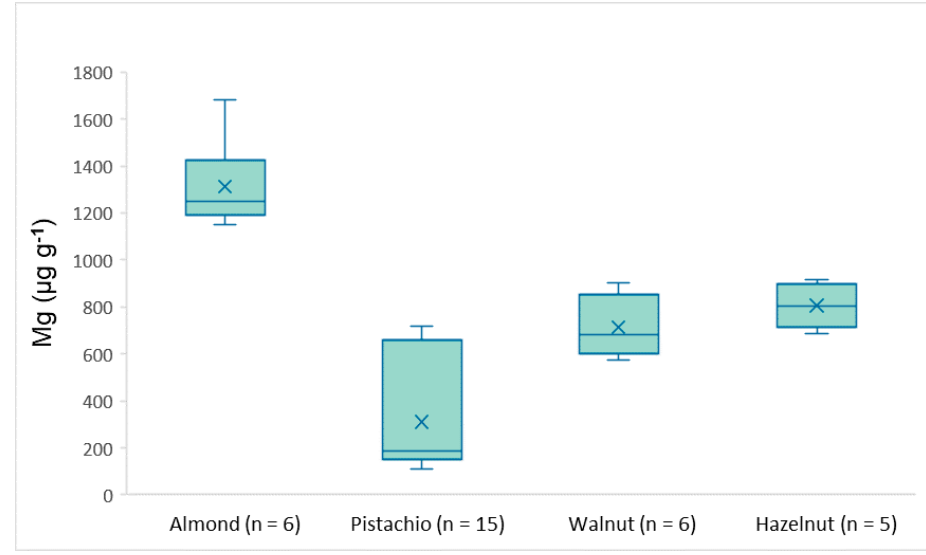
Figure 2. Box and Whisker plot for the concentrations of magnesium among different nut species. In the case of iron, Figure 3 indicates that the highest average concentration was de- termined in almonds (48 μ g g − 1 ) followed by hazelnuts (37.5 μ g g − 1 ), walnuts (34.4 μ g g − 1 ) and pistachios (12.8 μ g g − 1 ). Concerning the concentration of iron, the ANOVA showed that there was a significant statistical difference for the analyzed almonds, pistachios, wal- nuts and hazelnuts ( p = 8 × 10 − 6 ).